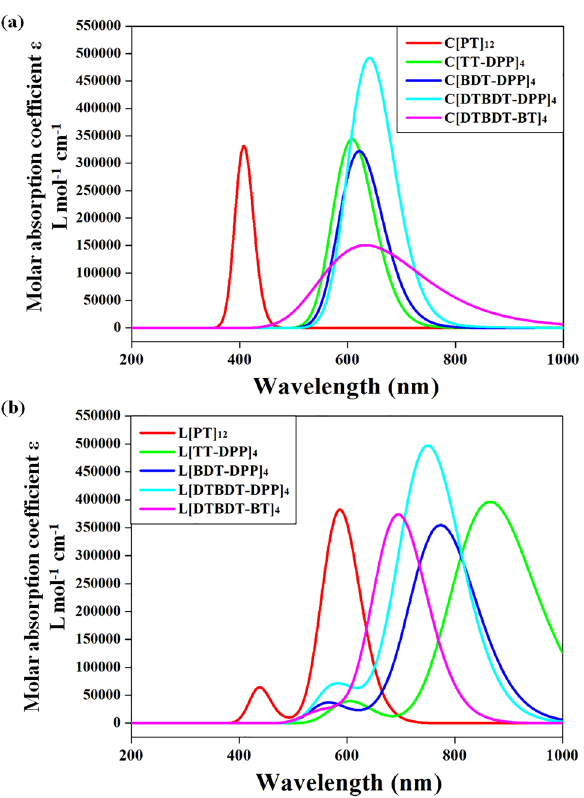
Figure 6. Graphical representation of absorption wavelengths of larger ( a ) linear and ( b ) macrocyclic compounds calculated at mPW1PW91/6-31G(d,p) level of